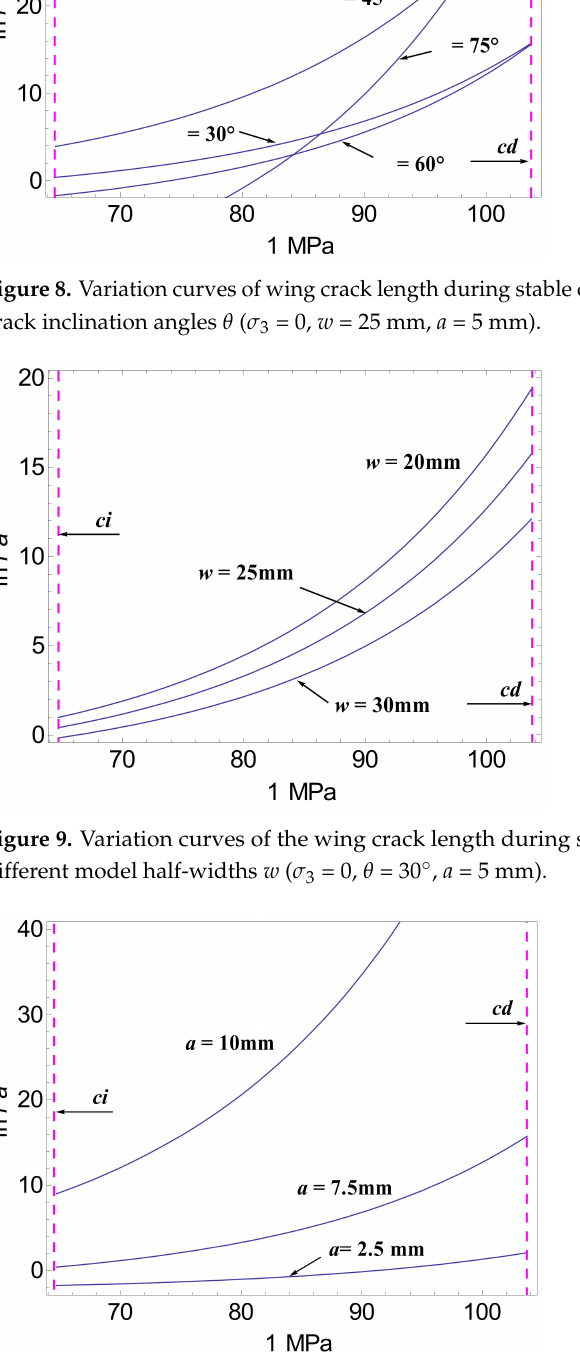
Figure 10. Variation curves of the wing crack length in rock crack stable propagation stage under different initial crack lengths a ( σ 3 = 0, θ = 45 ◦ , w = 25